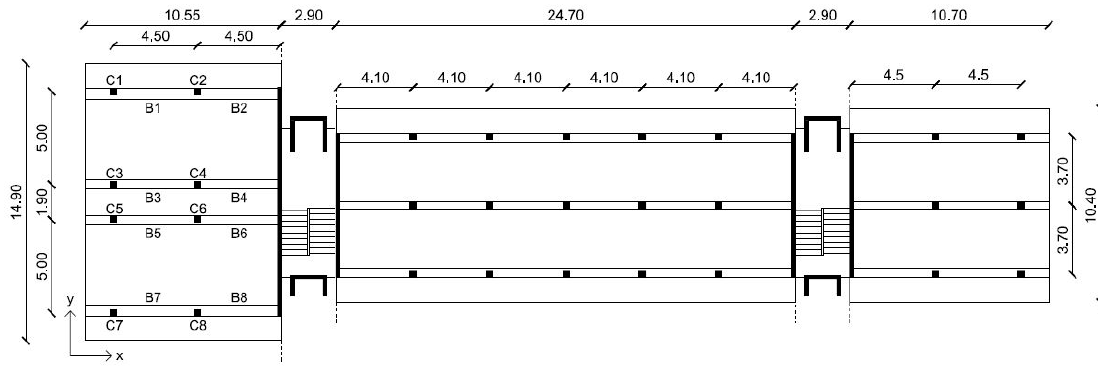
Figure 13. Plan of the first floor of building B.